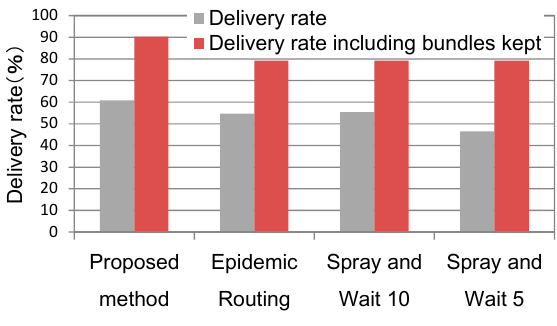
Figure 9. Delivery rate (rate at which bundles are delivered to